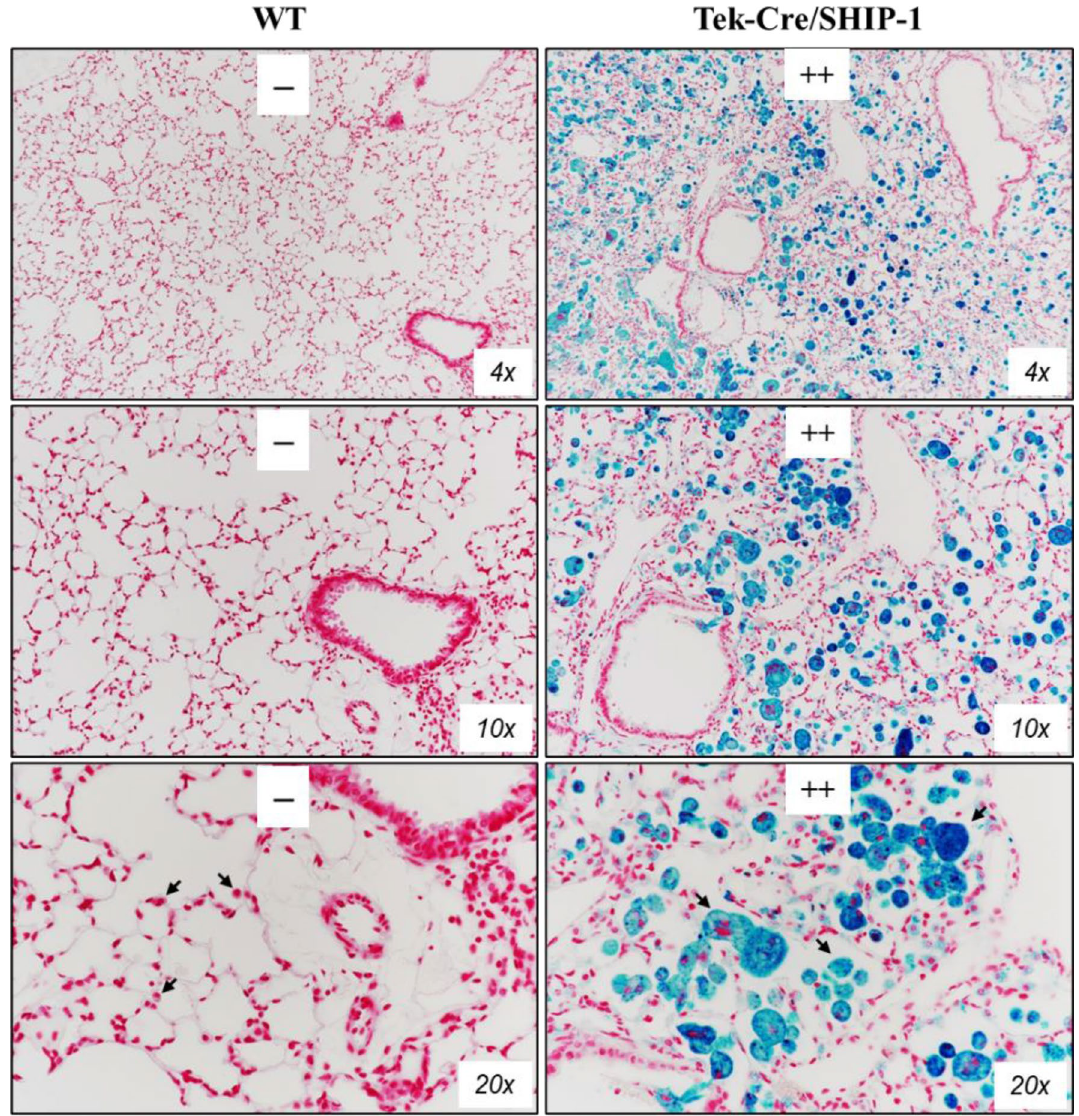
Figure 6. Hemosiderin deposition in the lung tissues of Tek-Cre/SHIP-1 mice. Prussian blue stained lung sections from WT and Tek-Cre/SHIP-1 mice are shown under different magnifications. Arrows point to macrophages in WT lung and groups of macrophages in Tek-Cre/SHIP-1 lung. Pathology scores were assigned by a pathologist and through application of the ImageJ software and its associated color deconvolution that initiated the pulmonary phenotype due to cell-intrinsic SHIP-1 deficiency have not been identified. Several attempts have been made. Studies using conditional knockout mice found that cell-specific deletion of SHIP-1 in macrophages, dendritic cells (DC), B cells and T cells resulted in some changes in cellular and immunological functions, without causing spontaneous lung inflammation 21,23,24,56 . These results suggested that other cell types may be important in the initiation of lung inflammation in SHIP-1 deficient mice. Also, the early and spontane- ous nature of the inflammatory phenotype suggest an involvement of innate immune cells. However, a role of innate lymphoid cells type 2 (ILC2) cells has not been examined in this context. To address this issue, we selectively deleted SHIP-1 in hematopoietic progenitor cells using the Tek promoter controlled Cre recombination in homozygous Tek-Cre/SHIP-1 mice and examined the inflammatory pulmonary phenotype. Tek-Cre directed deletion of genes has been utilized to target endothelial cells and hematopoietic cells 35–37 . Flow cytometry analysis of cells isolated from spleen and lung tissues of WT mice showed that the majority of CD45 + leukocytes express SHIP-1. However, when the SHIP-1 gene was targeted by Tek-Cre, only a small percentage of CD45 + cells from Tek-Cre/SHIP-1 mice remain positive for SHIP-1, although the total numbers of CD45 + cells were comparable in these mice and WT mice. Thus, the Tek-Cre system established conditional knockout of the SHIP-1 gene in leukocytes. It has been reported that Tek-Cre can lead to deletion of target genes in both hematopoietic cells and endothe- lial cells 35–37 . To confirm the cell-specific effects, we also generated VEC-Cre/SHIP-1 mice in which Cre is